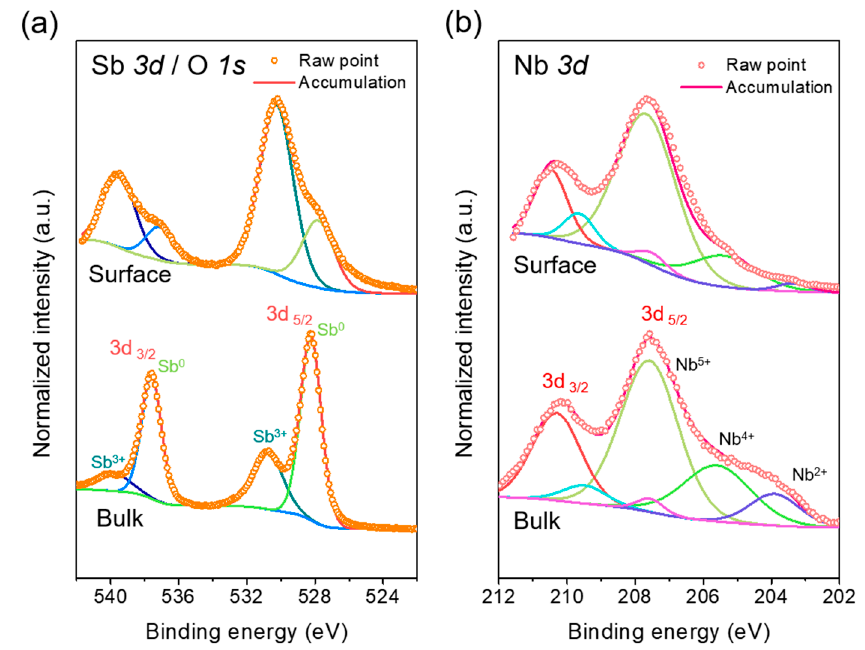
Figure 3. XPS core-level spectra of the composite: ( a ) Sb 3d/O 1s and ( b ) Nb 3d.